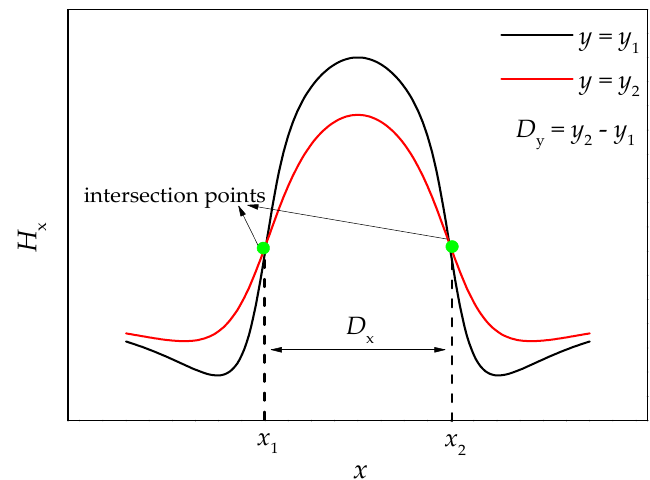
Figure 3. The schematic diagram of what D x means. H x : magnetic field intensity component; x 1 , x 2 : the x coordinates when two H x curves intersect. D x : the distance between two intersection points; D y : the difference between two lift off heights.